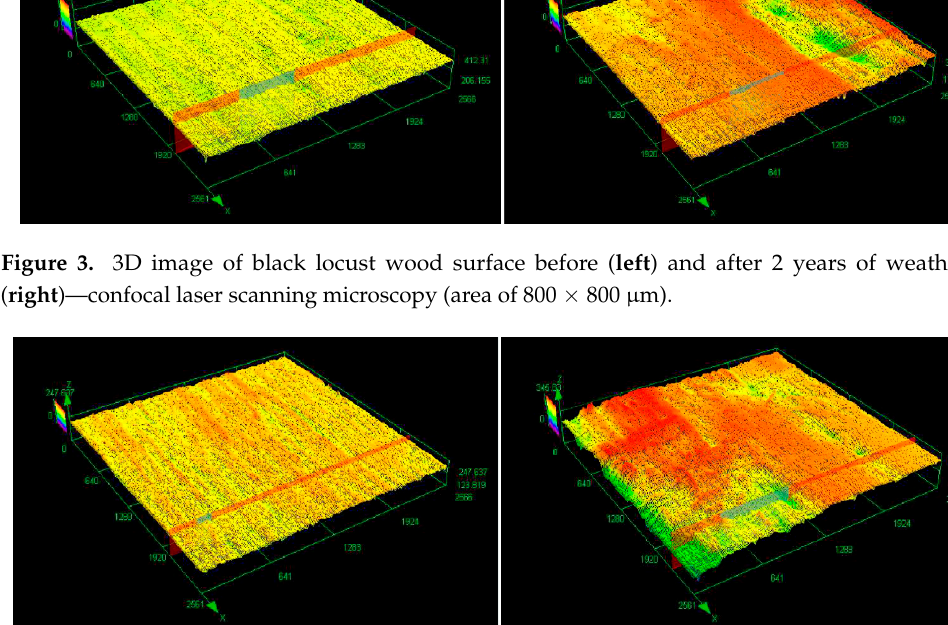
Figure 5. 3D image of alder wood surface before ( left ) and after 2 years of weathering ( right )— confocal laser scanning microscopy (area of 800 × 800 μ m).